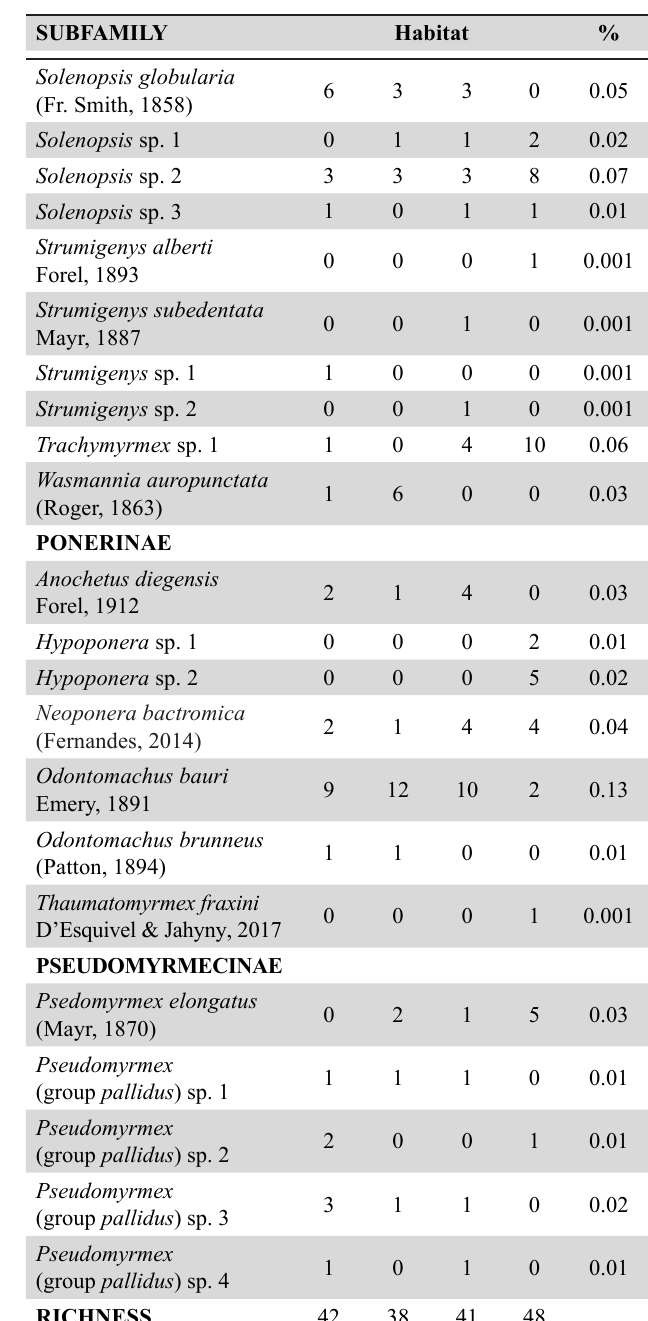
Table 2 . Ant frequency (0 - 100%), in small, medium large and continuous microhabitats in Parque das Dunas. SMA = Small, MED = Medium, LAR = Large, CON = Continuous Area. (Continuation)